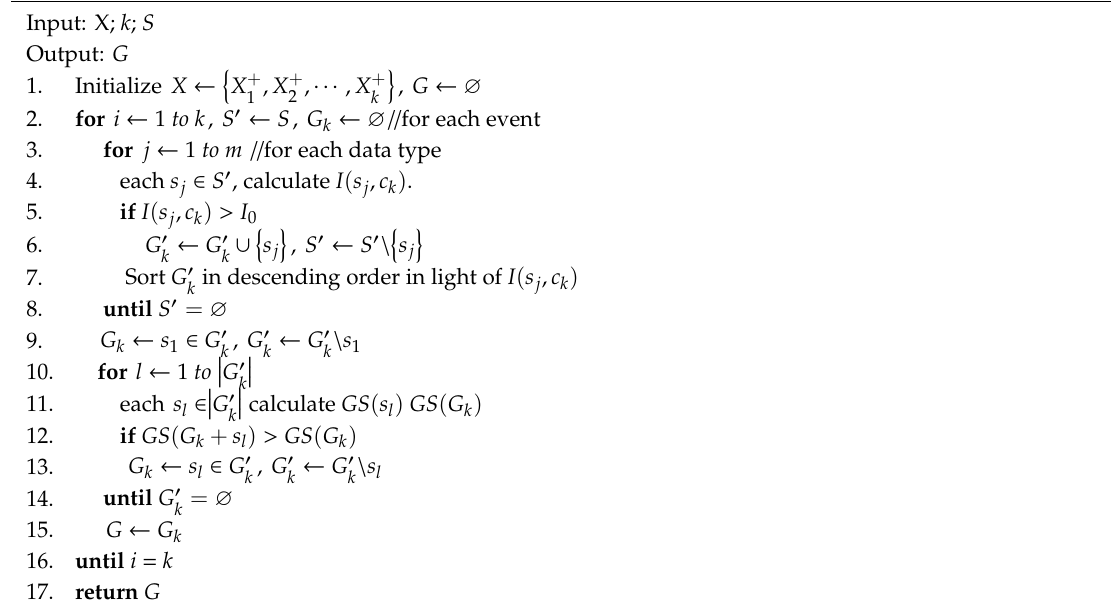
Algorithm 1 Sensing data type selection based on the